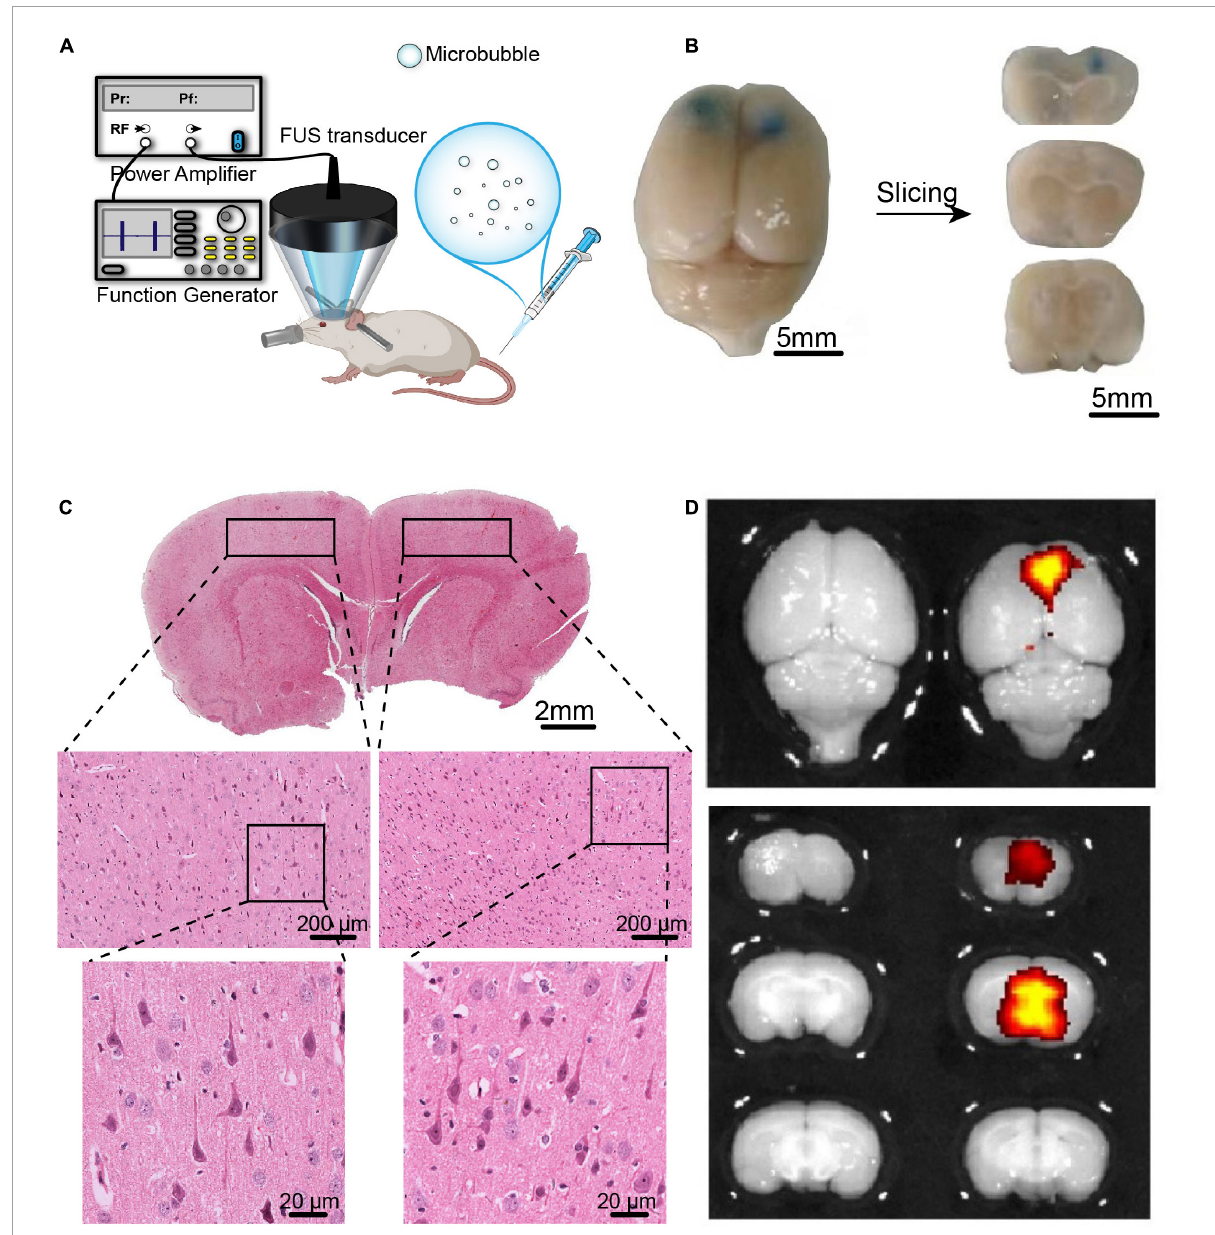
FIGURE3 The BBB opening induced by FUS combined with BDNFp-CMBs. (A) Illustration of the experimental platform for FUS and BDNFp-CMBs to open the BBB. (B) BBB opening area after a single treatment of FUS combined with BDNFp-CMBs revealed by Evans blue extravasation. Bilateral prefrontal cortical regions were sonicated. (C) HE staining of the rat brain coronal section after the BBB opening in rats. (D) Fluorescence images of EB in the rat brains indicating success BDNF transfection in the sonicated brain